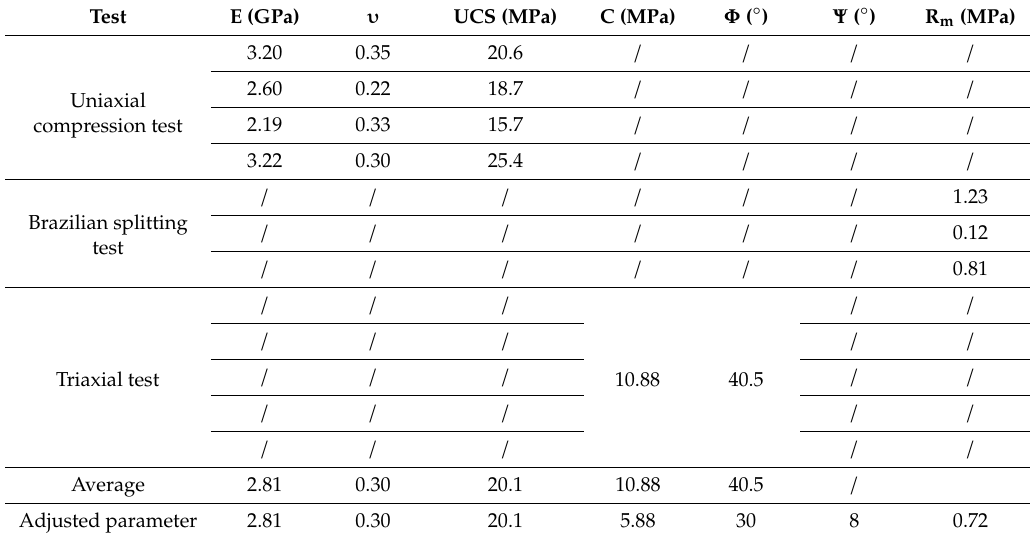
Table 1. Mechanical parameters of coal